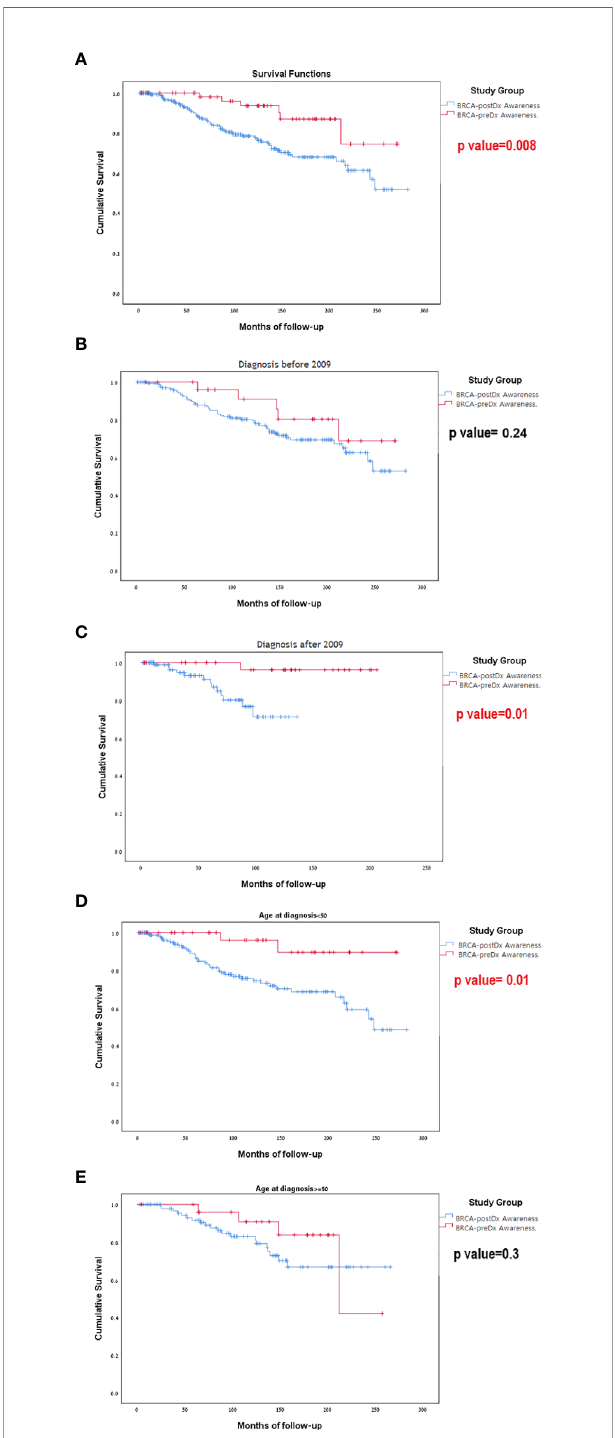
FIGURE 3 | Kaplan-Meier curves for overall survival. (A) BRCA-preDx awareness cohort and BRCA-postDx awareness cohort. (B) BRCA-preDx awareness cohort and BRCA-postDx awareness cohort before 2009. (C) BRCA-preDx awareness cohort and BRCA-postDx awareness cohort after 2009. (D) BRCA-preDx awareness cohort and BRCA-postDx awareness cohort before the age of 50 years. (E) BRCA-preDx awareness cohort and BRCA-postDx awareness cohort after the age of 50